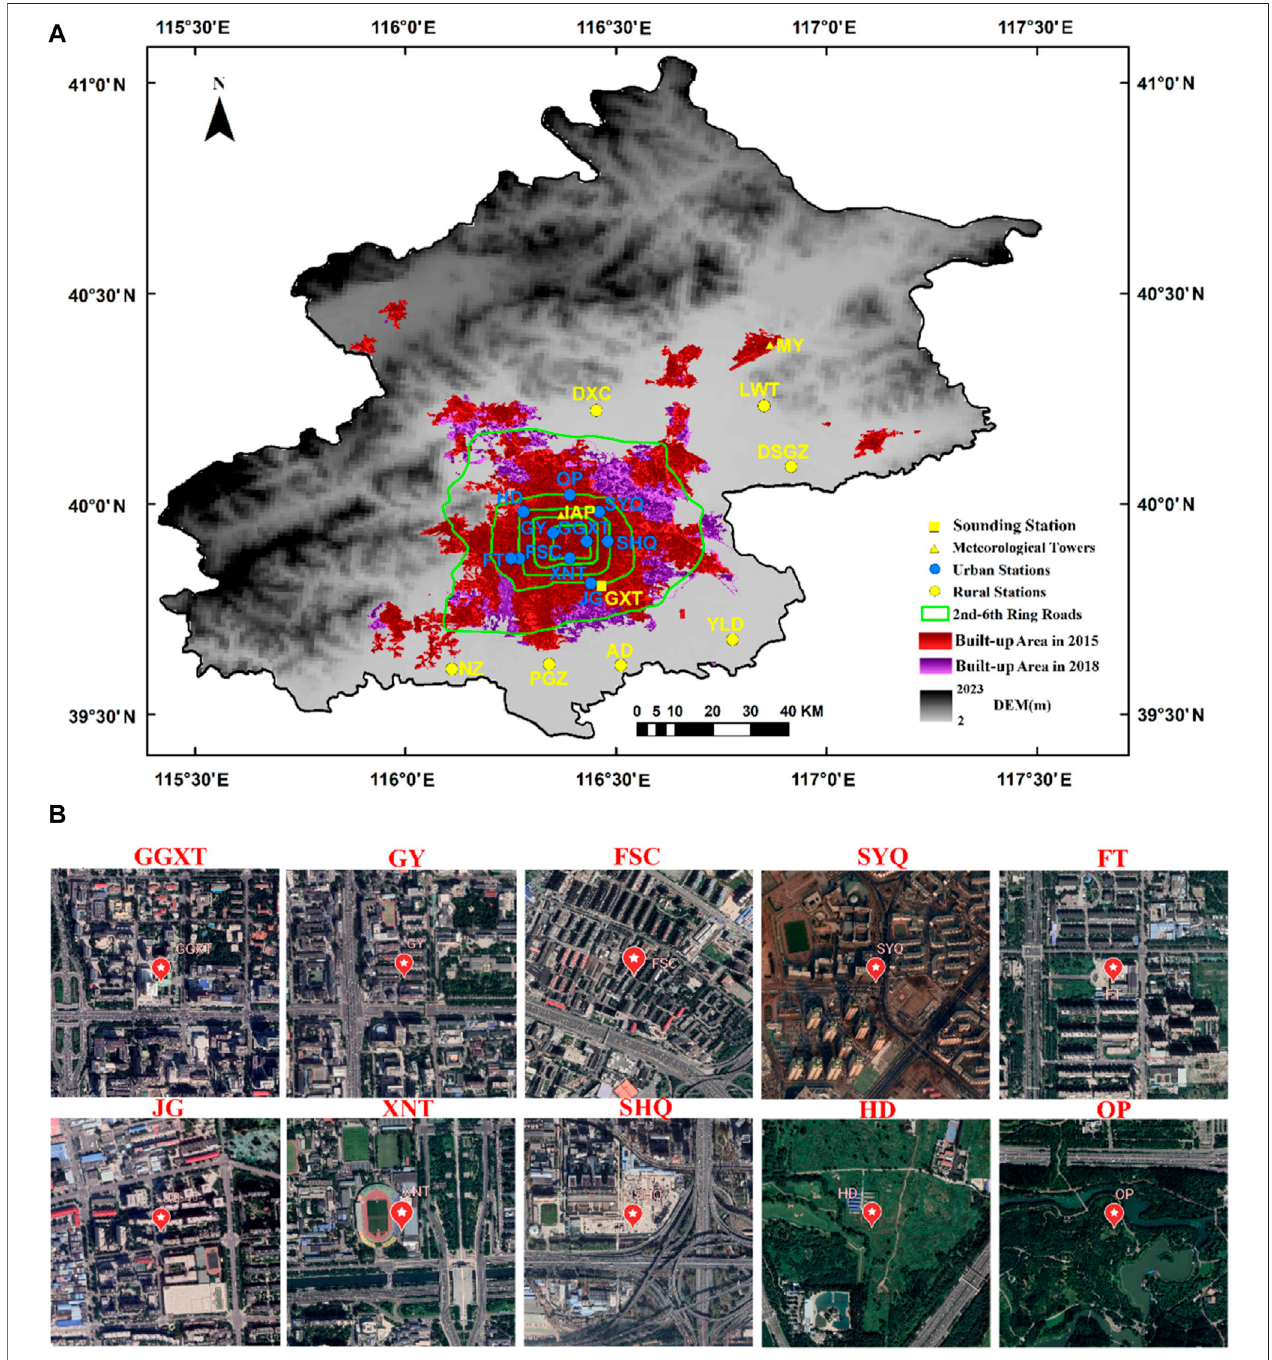
FIGURE1|(A) GeographicallocationsofreferencestationswithintheboundariesofBeijing. (B) GoogleEarthimagesofurbanstations.Thebuilt-upareasdatacan be accessed at https://zenodo.org/record/4034161#.YFc56driuUl.